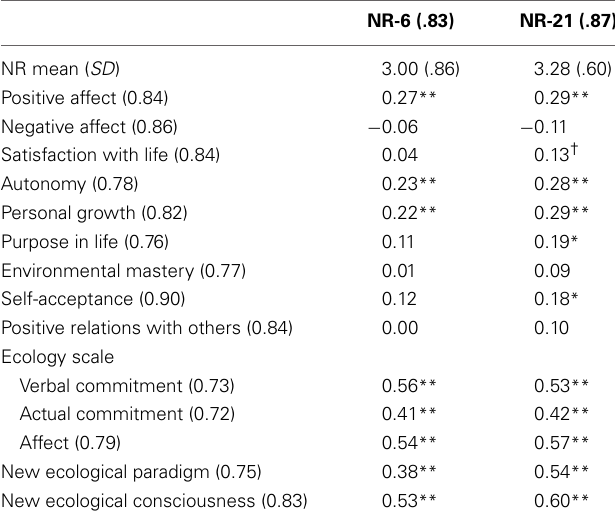
Table 1 | Study 1—nature relatedness correlations with well-being and environmental measures in students ( n =